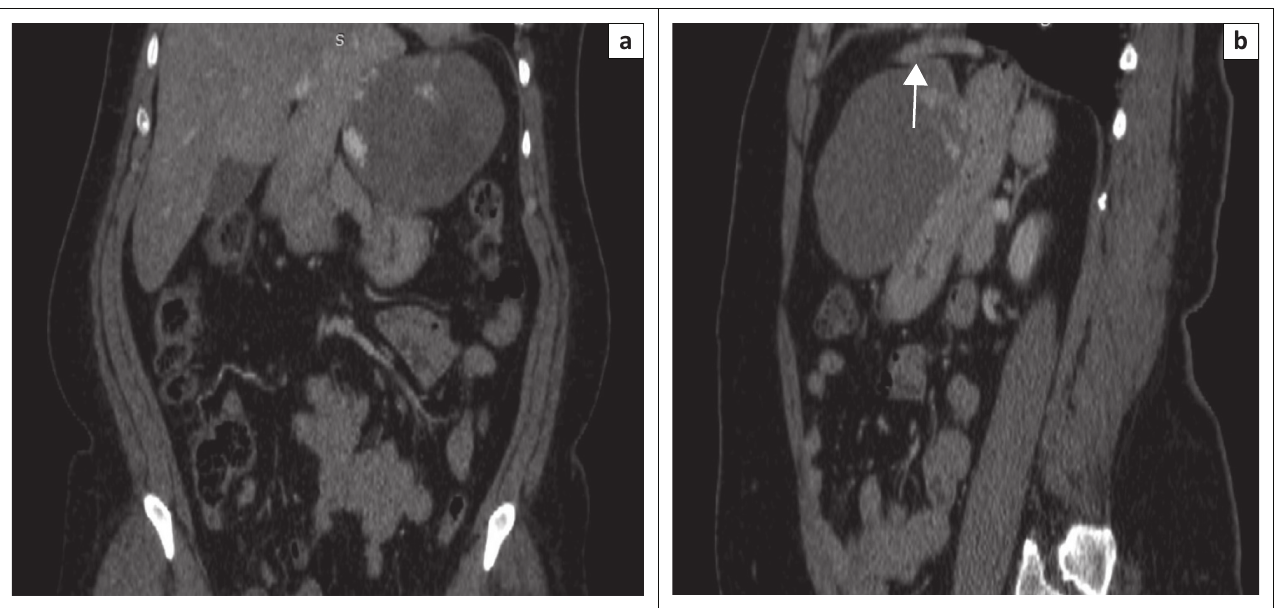
FIGURE 2: (a) Coronal reformat image shows the mass scalloping of the left lobe of the liver. (b) Sagittal reformat image shows the mass abutting a wide region of the lesser curvature of the stomach and appearing inseparable from it. However, close inspection shows a sliver of tissue (arrow) extending between the left lobe of the liver and the mass.